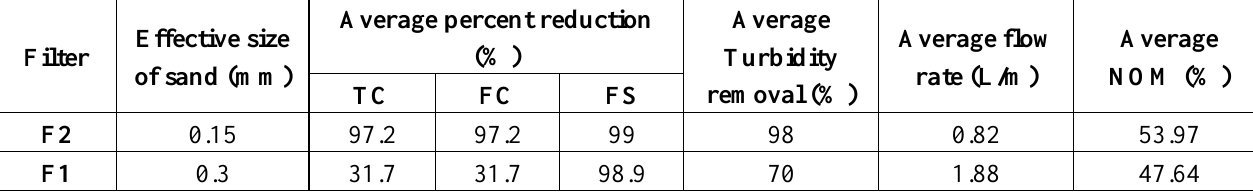
Table 9. Effects of sand size on bio-sand filter